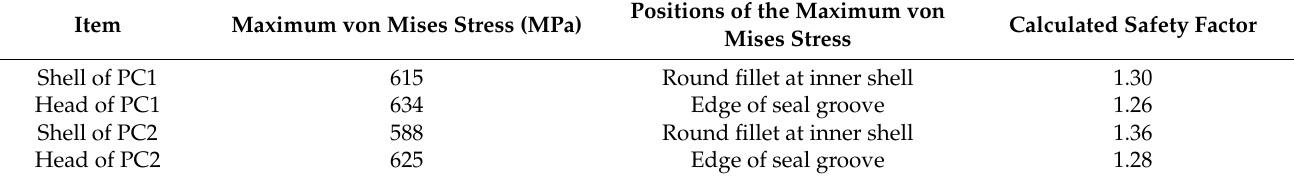
Figure 8. ( a ) The von Mises stress cloud map for lifting conditions; ( b ) the structural deformation cloud map for lifting conditions.